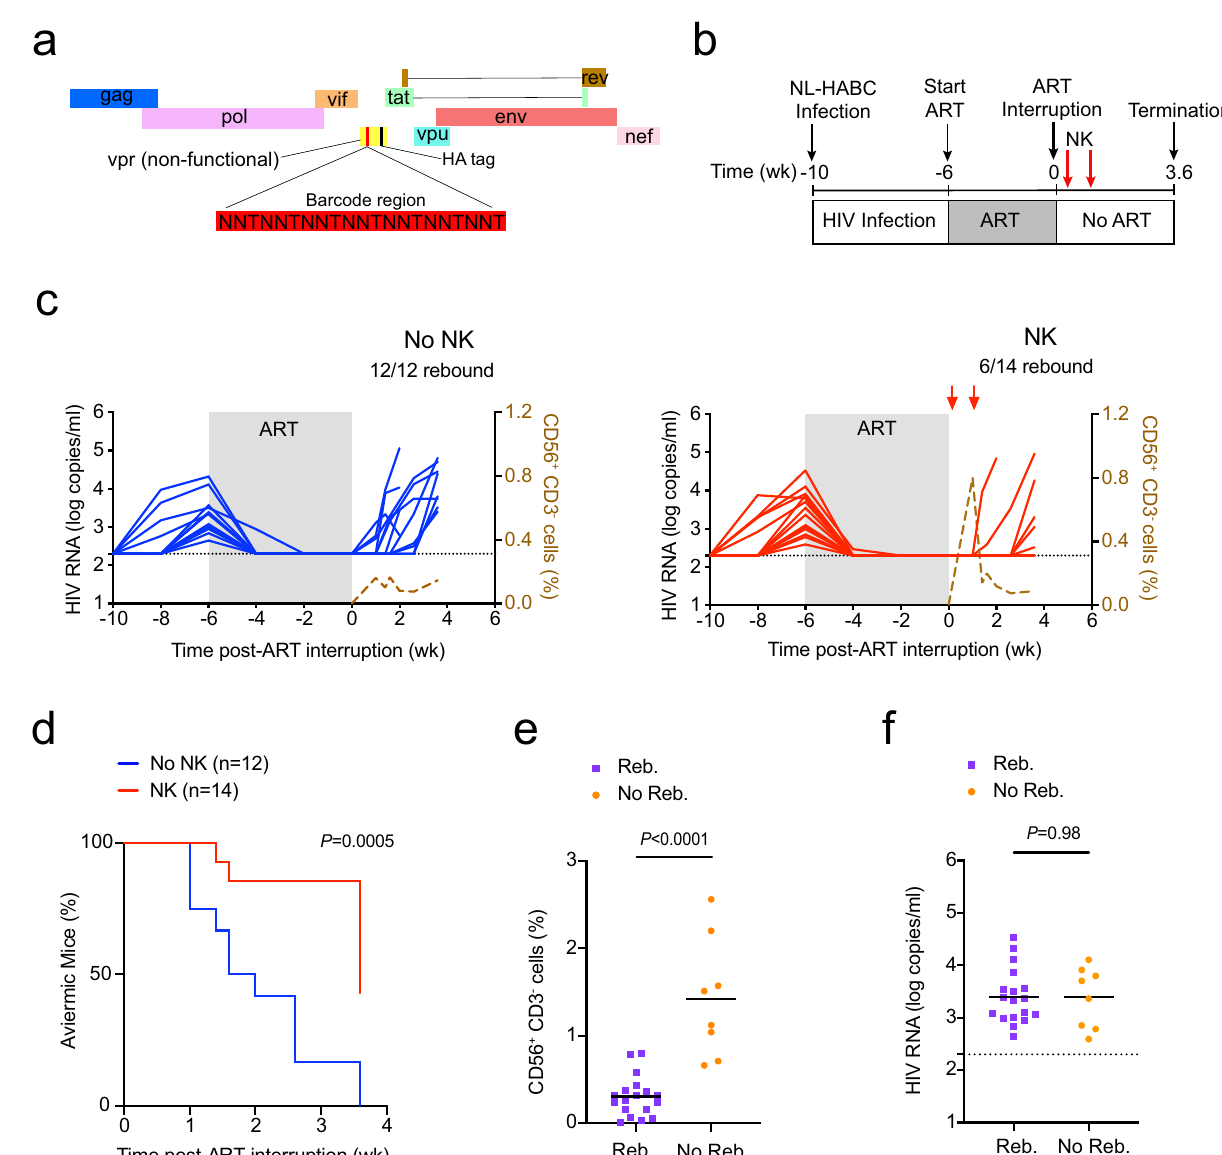
Fig. 2 NK cells delay viral rebound after ART interruption. a 21 bp barcode region (red) constrained by a thymine every third nt was inserted upstream of the hemagglutinin “ HA ” tag in a nonfunctional vpr of the HIV strain NL-HA 8 . b Schematic representation of experiment; acute infection of NSG-BLT with NL-HABC. c Longitudinal plasma viral loads for each infected animal at various timepoints in the No NK (blue) and NK (red) groups. Gray shading indicates ART treatment period of 6 weeks. A dashed brown line indicates the median frequency of CD56 + CD3 − cells detected in the blood. d Kaplan – Meier curves showing the frequency of aviremic mice after ART interruption. P value denotes statistically signi fi cant difference calculated by log-rank Mantel – Cox test. e Frequency of CD56 + CD3 − cells in the blood 5 days after the fi rst injection of NK cells among mice that rebounded “ Reb. ” (purple) or did not rebound “ No Reb. ” (orange) after ART discontinuation. f Plasma viral loads for each animal before ART was initiated. n = 12 biologically independent animals in the No NK group, n = 14 biologically independent animals in the NK group ( c , d ). n = 18 biologically independent animals in Reb. group, n = 8 biologically independent animals in the No Reb. group ( e , f ). The black dotted line indicates the detection limit of 2.3 log RNA copies per ml ( c , f ). Horizontal bars represent the means ( e , f ). P values were calculated using a two-tailed Mann – Whitney test ( e , f ). Results are pooled from two independent experiments. Source data are provided as a Source Data fi